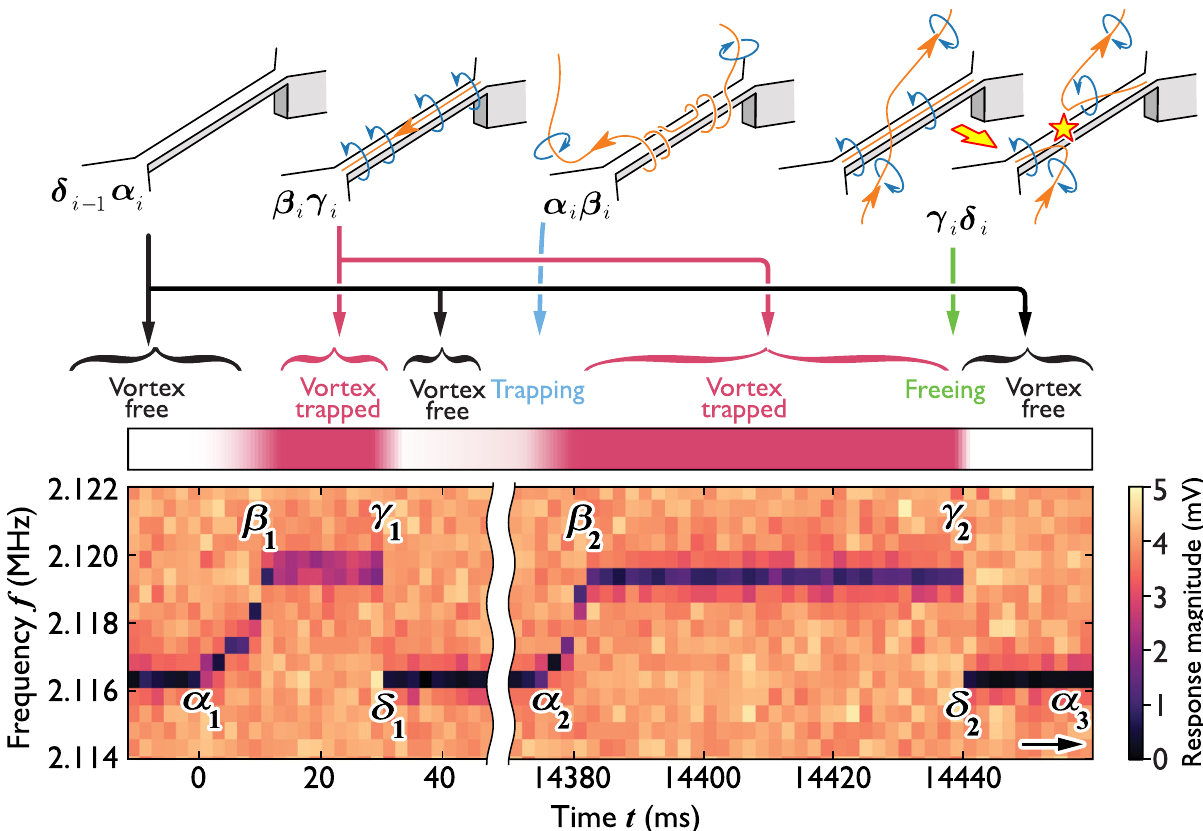
Fig. 2 The magnitude of the nanobeam response at each excitation frequency against time taken from the start of the fi rst event in heat-map format. Before point α 1 the beam is in the default vortex-free state. Between α 1 and β 1 a vortex interacting with the beam gradually raises the beam frequency by 3 kHz, fi nally becoming captured along the entire length of the beam at β 1 . From β 1 to γ 1 the resonance is stable for 20 ms. The captured vortex interacts with a nearby vortex and at point γ 1 / δ 1 the system suddenly resets via reconnection of the trapped and attracted vortices and the beam resonance jumps back to the vortex-free state. After 14.35 s a second event at α 2 occurs with similar features. The cartoons along the top of the fi gure sketch the broad processes involved, although the precise details of the capture and release mechanisms are not completely